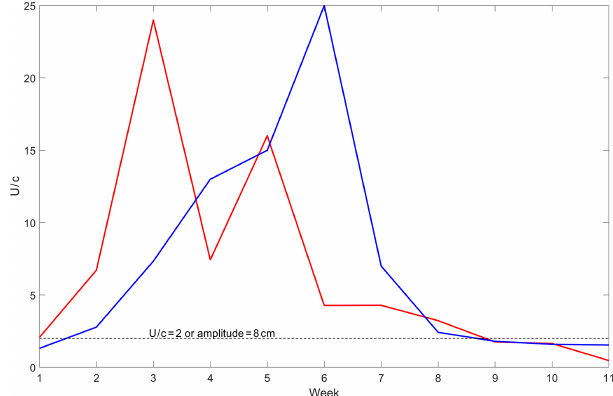
Figure 5. The advective nonlinearity parameter U/c (ANP). The thick red (blue) curve indicates the ANP of the observations (As_exp experiment) of AE2, the dashed line indicates the value of eddy amplitude at 8cm or the ANP greater than 2.